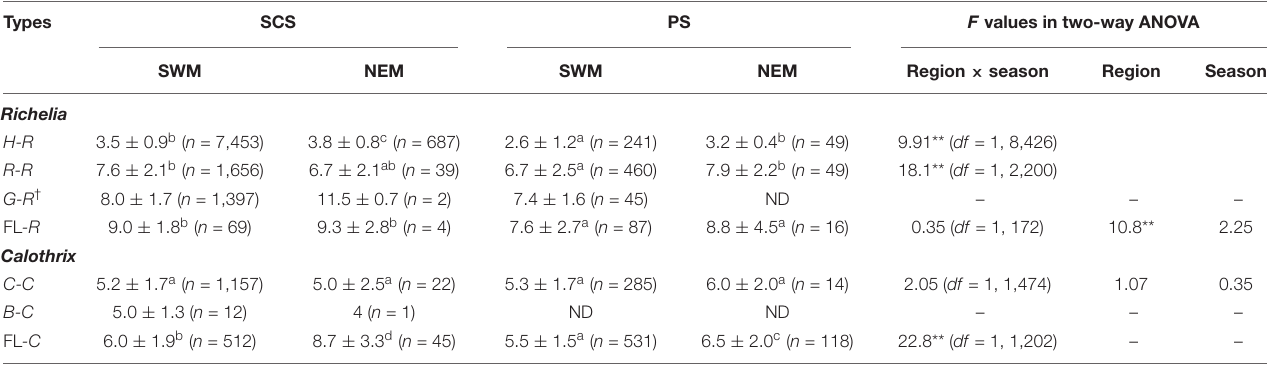
TABLE 2 | Trichome length of Richelia and Calothrix in the SCS and the PS during SWM and NEM.